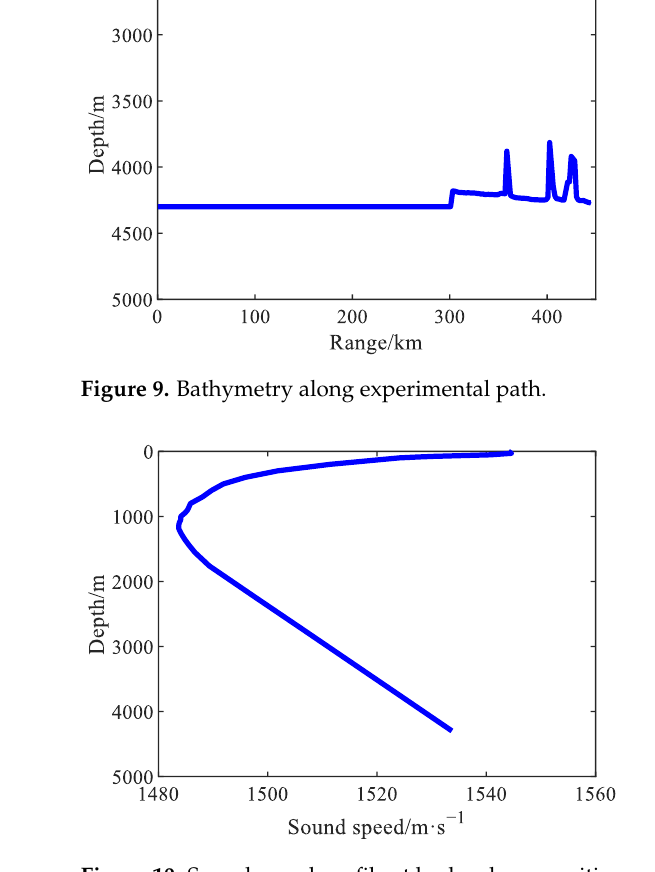
Figure 10. Sound speed profile at hydrophone position.